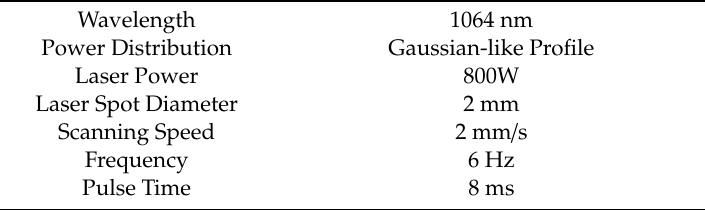
Table 3. Parameters in the Nd: YAG Laser Surface-Hardening Process.